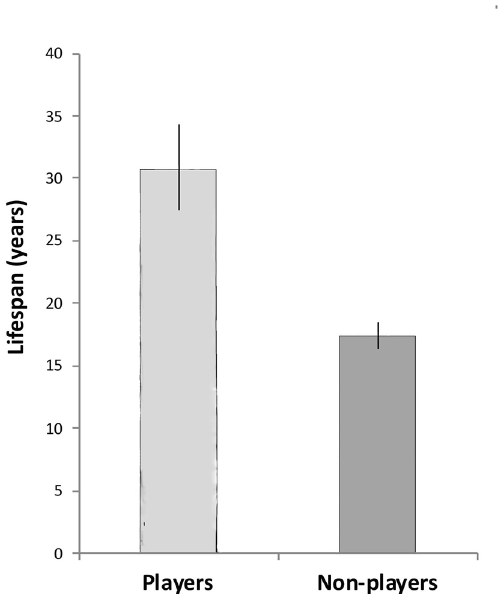
Figure 1. Lifespan (in years) of players (N = 35) compared to non-players (N = 42). Means and standard errors are presented. Note that species that play live twice as long as those that do not play ( p = 0.0007, see text for details).